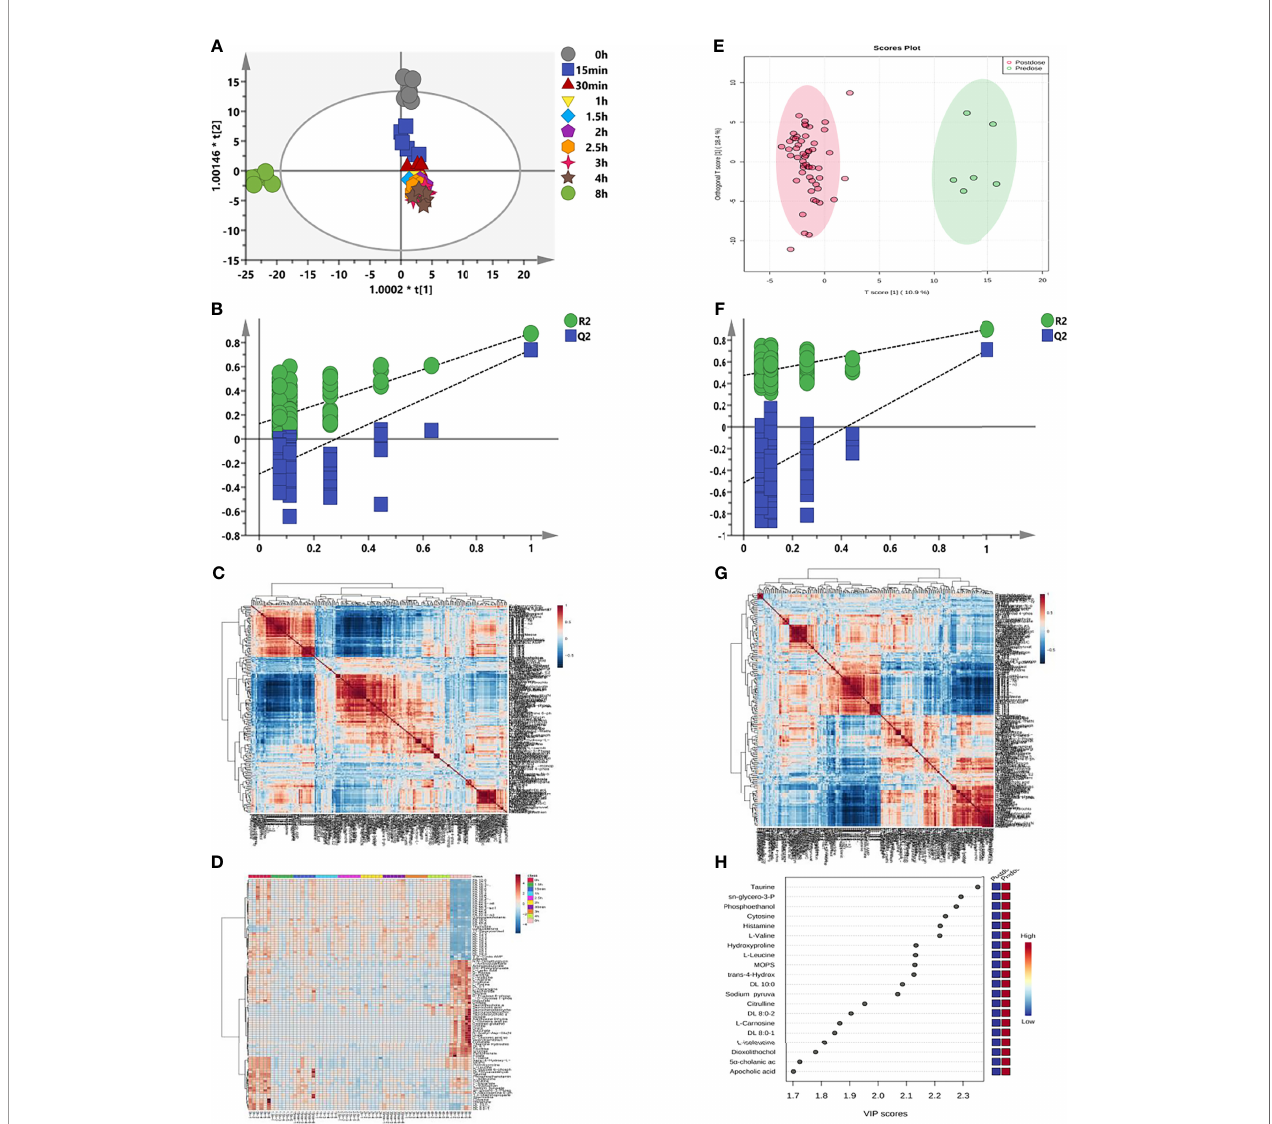
FIGURE 5 | Longitudinal and transversal metabolic pro fi les of sotorasib. (A) Longitudinal orthogonal projection to latent structures discriminant analysis (OPLS-DA) score plot according to the different time points. (B) Random permutation test with 200 iterations from (A) for longitudinal metabolomics. (C) Longitudinal hierarchical cluster analysis (HCA) of the metabolite – metabolite correlations in response to sotorasib treatment. (D) Longitudinal heatmap clustering of the changed metabolites. (E) Transversal OPLS-DA plot. (F) Transversal permutation test with 200 iterations. (G) Transversal HCA correlation analysis before and after sotorasib treatment. (H) Transversal metabolomics for variable importance in the projections (VIP) values of the top 20 metabolites due to sotorasib